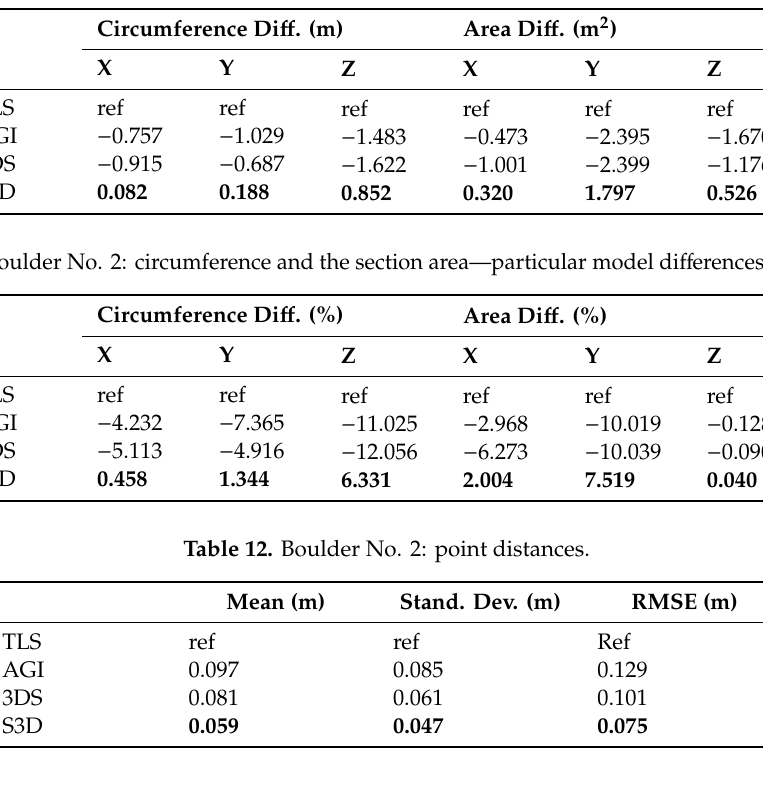
Table 10. Boulder No. 2: circumference and the section area—particular model di ff erences.